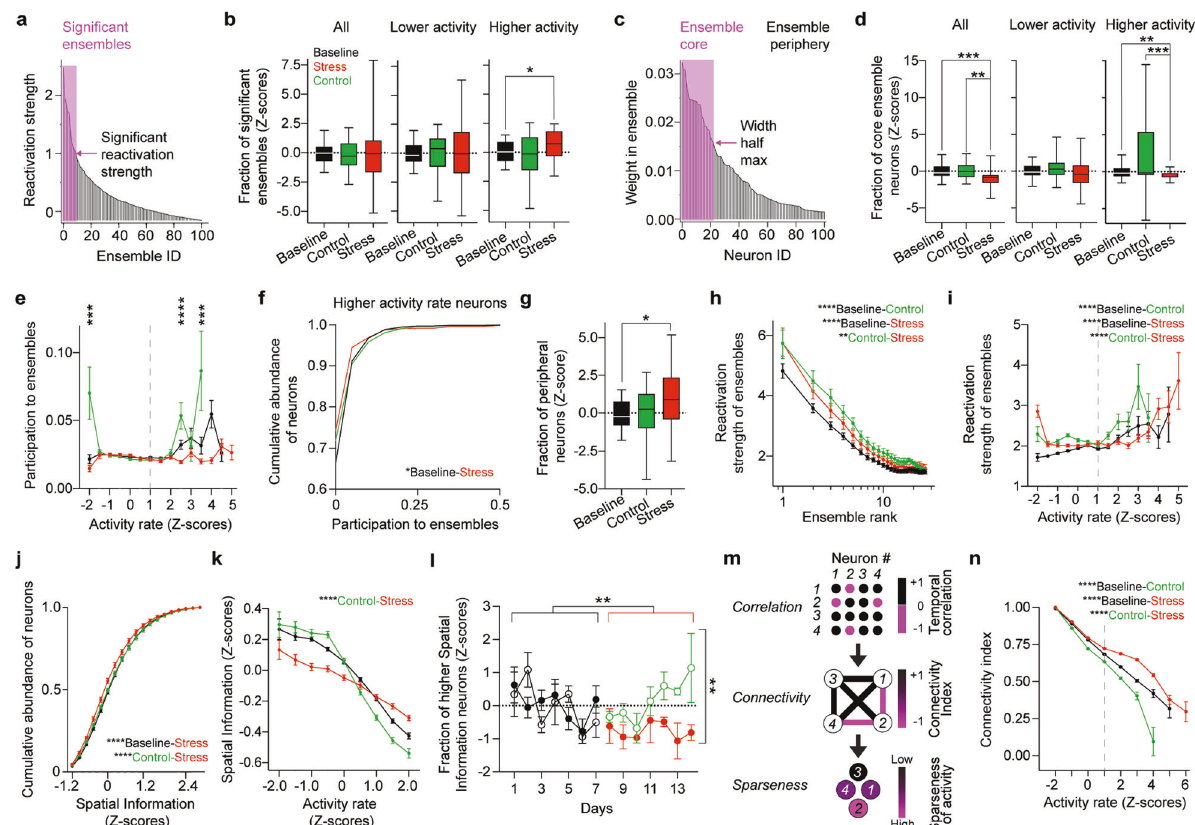
Fig. 2 Exposure to repeated stress impairs temporal and spatial codes of PNs in dCA1. a Neuronal ensembles (one mouse, one exploration session) sorted according to their normalized reactivation strengths. The arrow denotes the threshold for reactivation strength = 1, the pink rectangle indicates the signi fi cant ensembles corresponding to reactivation strength > 1. b Stress exposure did not change the fraction of signi fi cant ensembles among all (left) and lower activity neurons (middle) but signi fi cantly increased the fraction of signi fi cant ensembles among higher activity neurons (right). All: p B-C > 0.99, p B-S > 0.99, p C-S > 0.99; n B = 84, n C = 28, n S = 45. Lower activity: p B-C > 0.99, p B-S > 0.99, p C-S > 0.99; n B = 83, n C = 28, n S = 43. Higher activity: p B-C > 0.99, p B-S = 0.03, p C-S = 0.17; n B = 50, n C = 15, n S = 32. c Neurons (one mouse, one exploration session) sorted according to their weights within an ensemble. The arrow indicates the threshold that demarcates the ensemble ’ s core (pink rectangle). d Stress exposure decreased the size of ensembles ’ cores for all neurons (left: p B-C > 0.99, p B-S < 0.0001, p C-S = 0.0017; n B = 87, n C = 24, n S = 38), mainly due to higher activity neurons. Lower activity: p B-C = 0.84, p B-S = 0.38 p C-S = 0.09; n B = 83, n C = 28, n S = 40. Higher activity: p B-C = 0.25, p B-S = 0.0002, p C-S = 0.09; n B = 80, n C = 26, n S = 39. Box plots: medians and quartiles of mean fraction of signi fi cant ensembles b or of neurons participating in ensembles ’ cores d distributions per mouse per session. e Participation of high activity rate neurons in ensembles ’ cores increased with time, but stress exposure prevented this increase ( p -2 < 0.001, p -1.5, -1, -0.5, 0, 0.5, 1, 1.5, 2 > 0.13, p 2.5 < 0.0001, p 3 = 0.96, p 3.5 < 0.0001; n -2 > 68, n -1.5, -1, -0.5 > 702, n 0 > 2461, n 0.5, 1, 1.5, 2 > 285, n 2.5 > 75, n 3 > 18, n 3.5 > 5); Pairwise, two-tailed t -tests between control and stress per activity rate bin. P -values corrected for multiple comparisons with Holm- Š idák Method. Circles: mean ensemble participation index binned over activity rates. Error bars: s.e.m. Dashed line indicates the threshold for neurons with higher activity rates. f Stress exposure decreased the mean participation of higher activity rate neurons to ensembles ’ cores ( p B-C > 0.99, p B-S = 0.031, p C-S = 0.32; n B = 4445, n C = 1201, n S = 5863). g Stress exposure increased the fraction of neurons in ensembles ’ peripheries ( p B-C > 0.99, p B-S = 0.046, p C-S = 0.28; n B = 40, n C = 28, n S = 35). Box plots: medians and quartiles of mean fraction of neurons participating in ensemble ’ s periphery distributions per mouse per session. h Reactivation strength of ensembles increased with time, but to a lower extent upon stress exposure ( p B-C < 0.0001, p B-S < 0.0001, p C-S = 0.0072; n B = 1462, n C = 510, n S = 749; Two-Way ANOVA). Circles: mean reactivation strengths of ensembles index ranked according to decreasing values. Error bars: s.e.m. i Stress exposure increased the activity rates of neurons participating in ensembles with similar reactivation strengths ( p B-C S < 0.0001, p B-S < 0.0001, p C-S < 0.0001; n B = 25230, n C = 9575, n S = 11668). Circles: mean reactivation strengths of the ensembles in which each neuron took part binned over activity rates. Error bars: s.e.m. Dashed line indicates the threshold for neurons with higher activity rates. j Stress exposure decreased the amount of SI per neuron ( p B-C = 0.38, p B-S < 0.0001, p C-S < 0.0001; n B = 1152, n C = 396, n S = 540). k Stress exposure decreased the SI in neurons with lower activity rate and increased the SI in neurons with higher activity rate ( p B-C = 0.21, p B-S = 0.074, p C-S < 0.0001; n B = 9575, n C = 25,230, n S = 1168). Circles: mean SI binned over activity rates. Error bars: s.e.m. l Stress exposure decreased the fraction of neurons with higher spatial information ( p Bcontrol-Bstress > 0.99, p Bcontrol-C > 0.99, p Bstress-S = 0.0011, p C-S = 0.0014; n Bcontrol = 22, n Bstress = 37, n C = 26, n S = 29). Circles: mean fraction of higher SI neurons per mouse per session. Solid symbols, stress group. Empty symbols, control group. Error bars: s.e.m. m Schematic description of the transformation from correlation adjacency matrices to connectivity networks and their meaning in terms of temporal sparseness of activity. n Stress exposure increased co-activity and thus prevented the increase in sparseness of activity of dCA1 PNs ( p B-C S < 0.0001, p B-S < 0.0001, p C-S < 0.0001; n B = 14303, n C = 6054, n S = 9026). Circles: mean connectivity index binned over activity rates. Error bars: s.e.m. Dashed line indicates the threshold for neurons with higher activity rates. b , d , f , g , l Kruskal – Wallis test, p -values adjusted after Dunn ’ s corrections for multiple comparisons. i , j , k , n Two-way ANOVA, p -values adjusted after Tukey ’ s corrections for multiple comparisons.